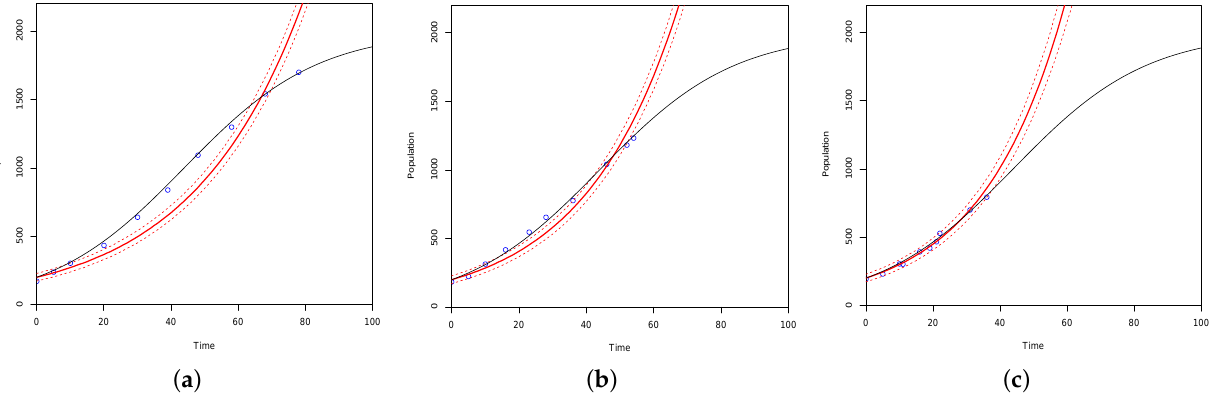
Figure 10. 10,000 MCMC samples are used in this simulation of a slow growth curve increasing at a 5% rate across 100 time points with a carrying capacity of 2000. Sequential optimality is used to find the ten best points for ( a ) I, ( b ) A Φ and ( c ) D Φ optimal designs. The optimal points are plotted in blue and fit with a solid red curve. The red dotted lines represent the 2.5% and 97.5% quantiles of the predicted values of the model. The black curve represents the ground truth